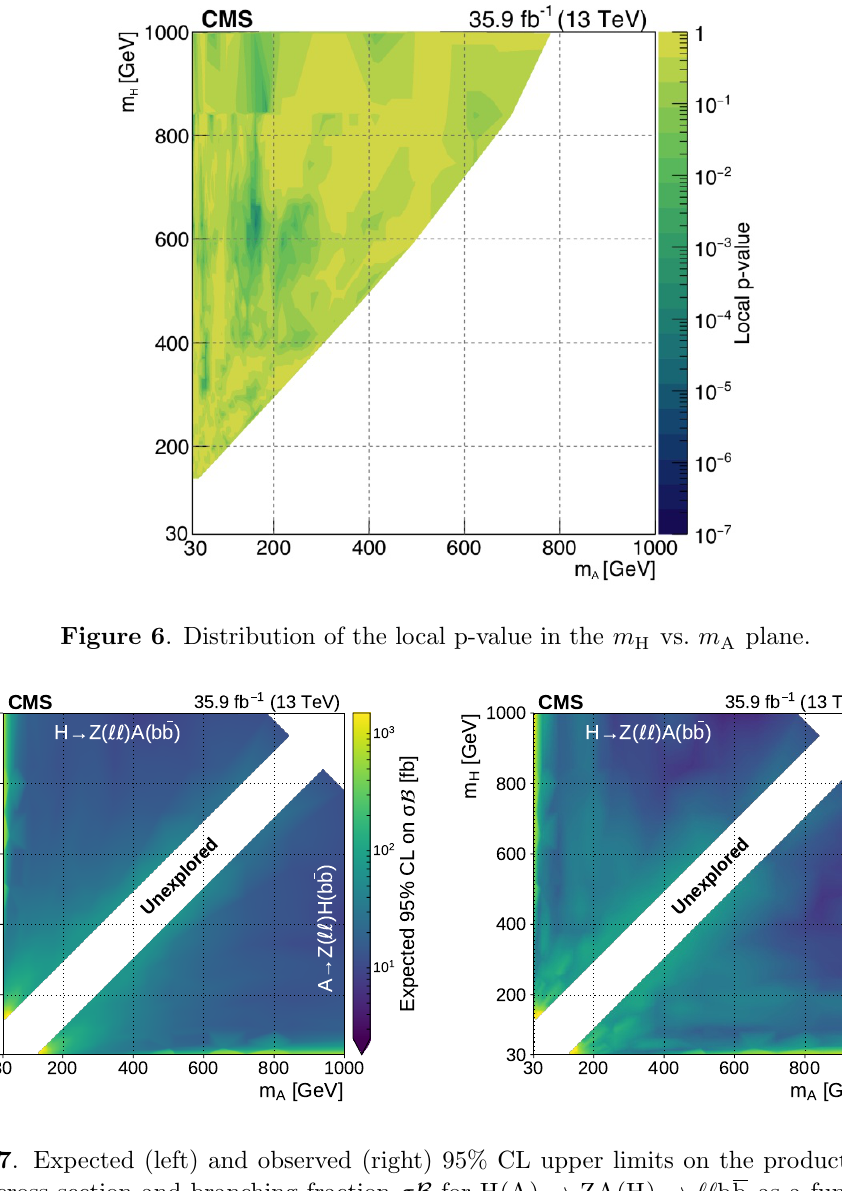
method, combining the ee and (cid:22)(cid:22) s